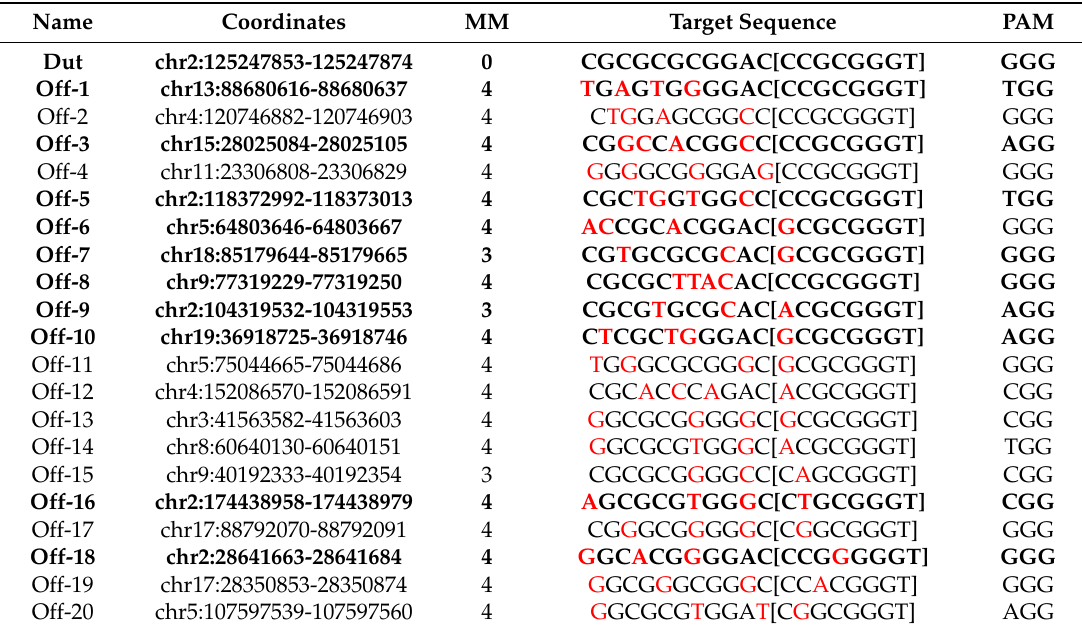
Table 1. Potential off-target sites predicted by CCTop—CRISPR/Cas9 target online predictor software.